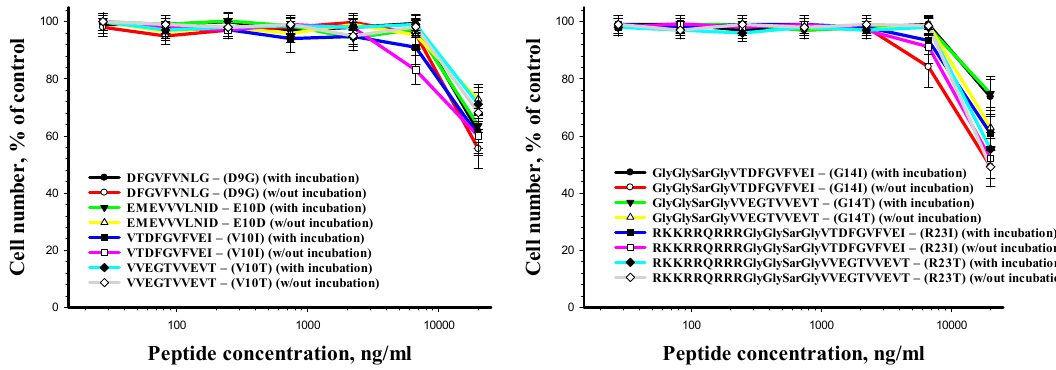
Figure 7. Human fibroblasts viability after peptide treatment as a function of peptide concentration.